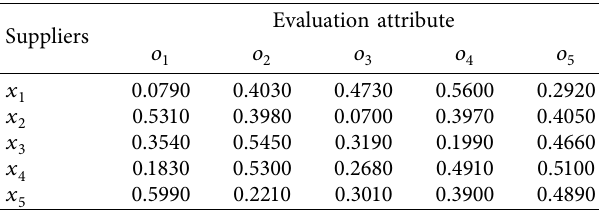
Table 2: Score matrix of attribute values of each alternative under each attribute.